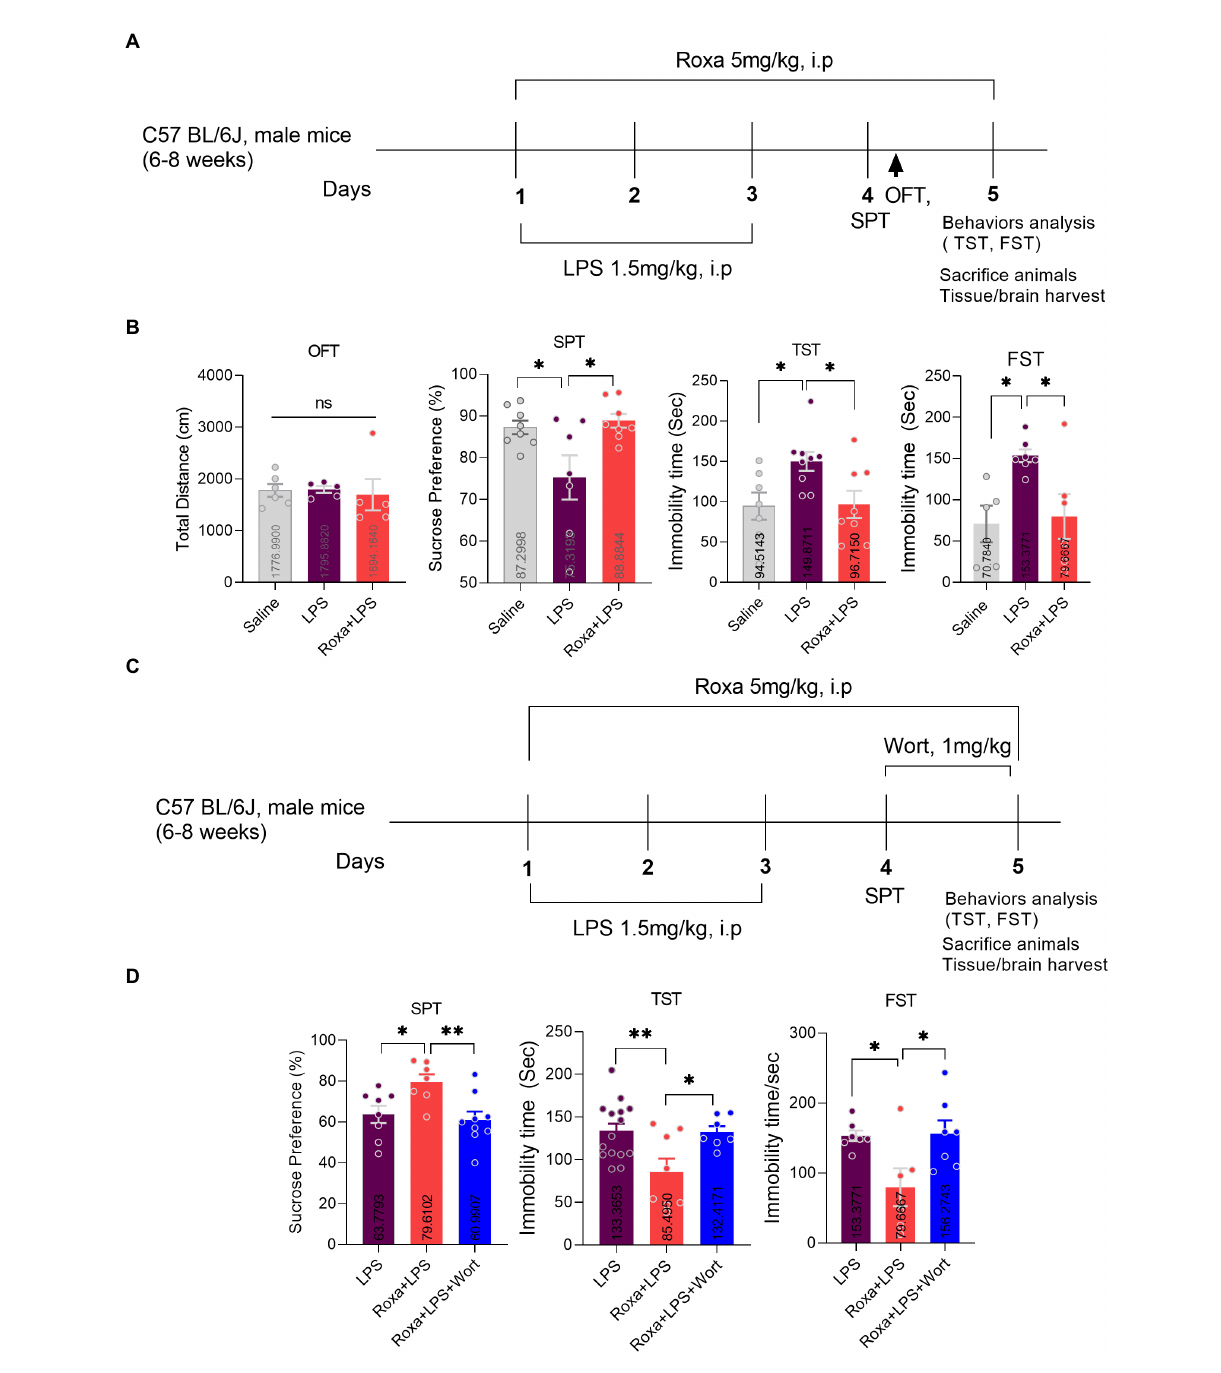
FIGURE 1 Roxadustat treatment reduced LPS-induced depressive-like behaviors via PI3K signaling. (A) Drugs treatment schedule, (B) open field test (OFT), forced swimming test (FST), and a sucrose preference test (SPT). (C) Drugs treatment schedule, (D) Sucrose preference Test (SPT), and tail suspension Test (TST). All the values are expressed as mean ± SEM: ANOVA followed by post hoc analysis. p = <0.05 were considered significant * p < 0.05, ** p < 0.01. ns: